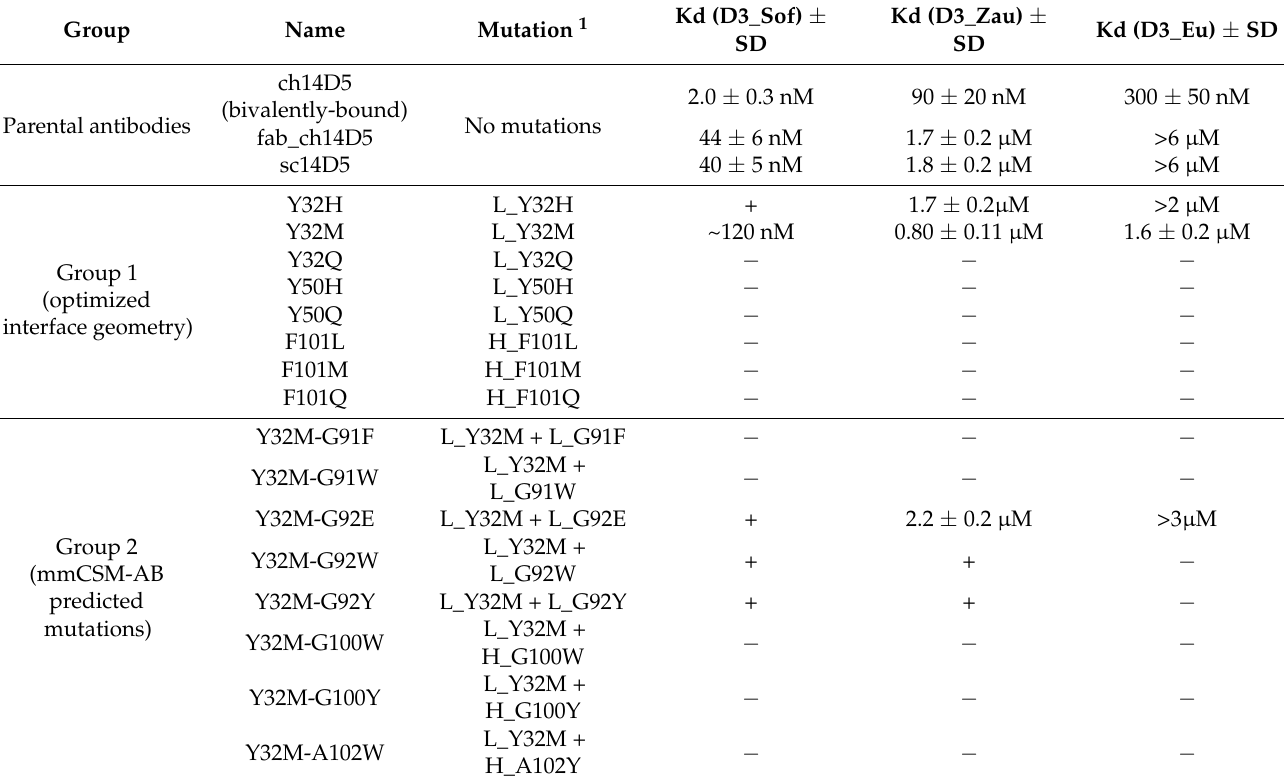
Table 1. Properties of parental antibodies and constructed mutant variants of the sc14D5 single-chain variable fragments. Group